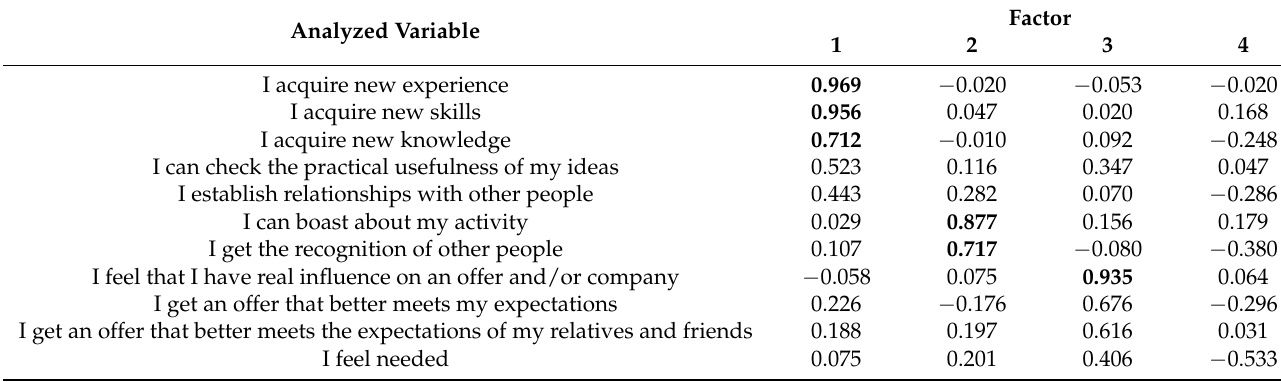
Table 3. Factor analysis of needs satisfied due to cooperation with offerors, according to respondents (for the total of